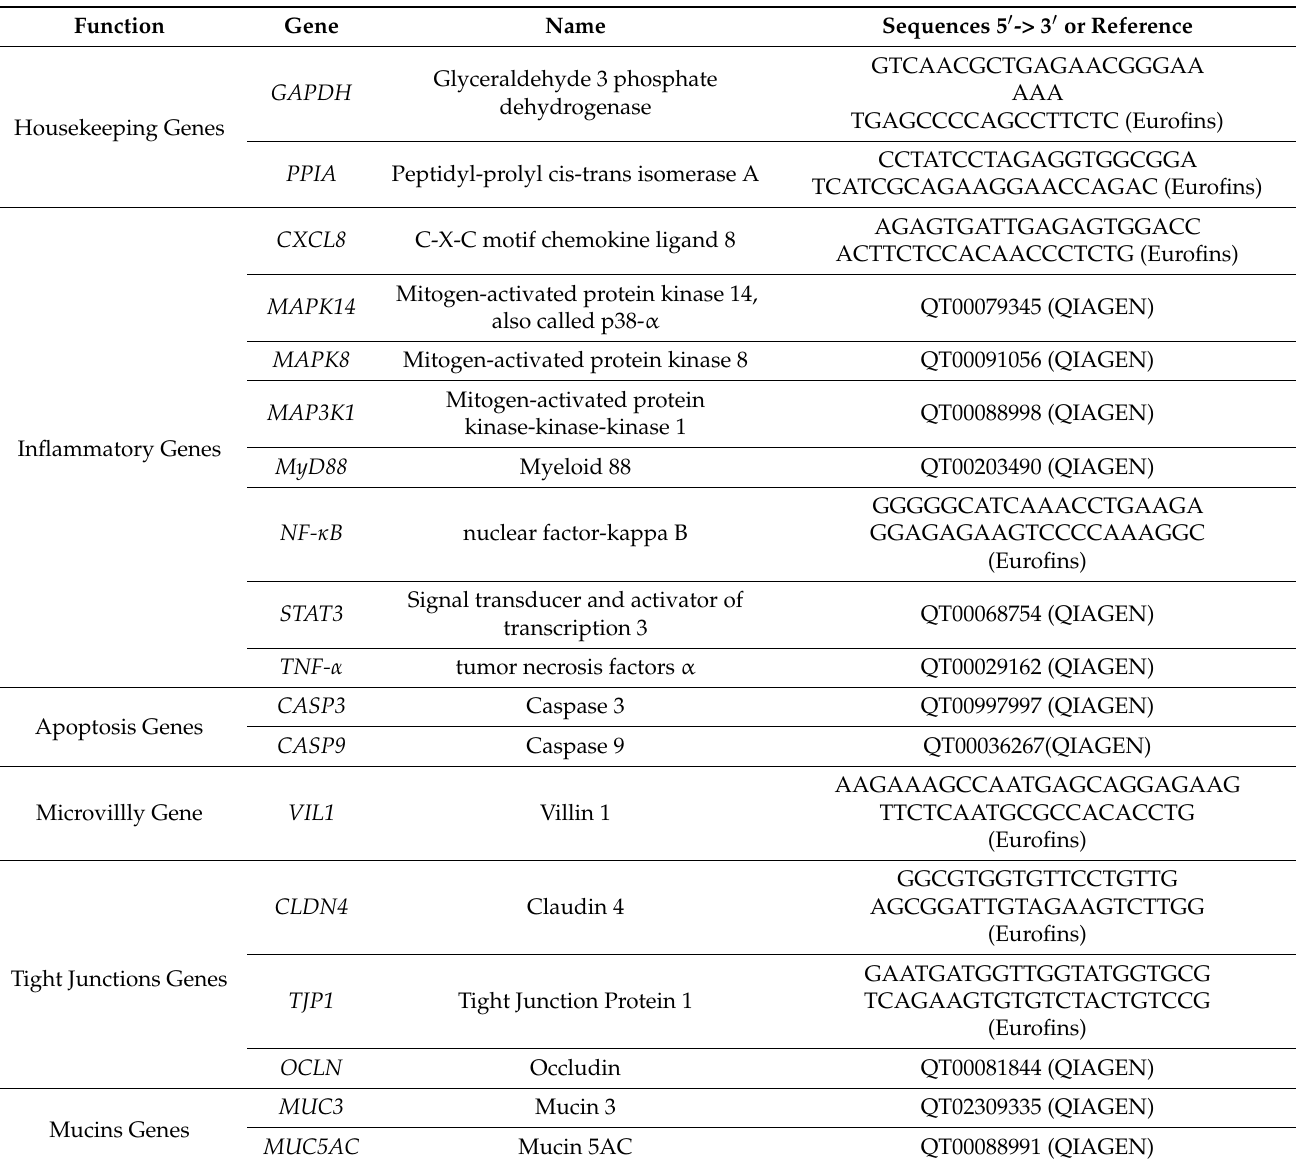
Table 1. List of primers used in the